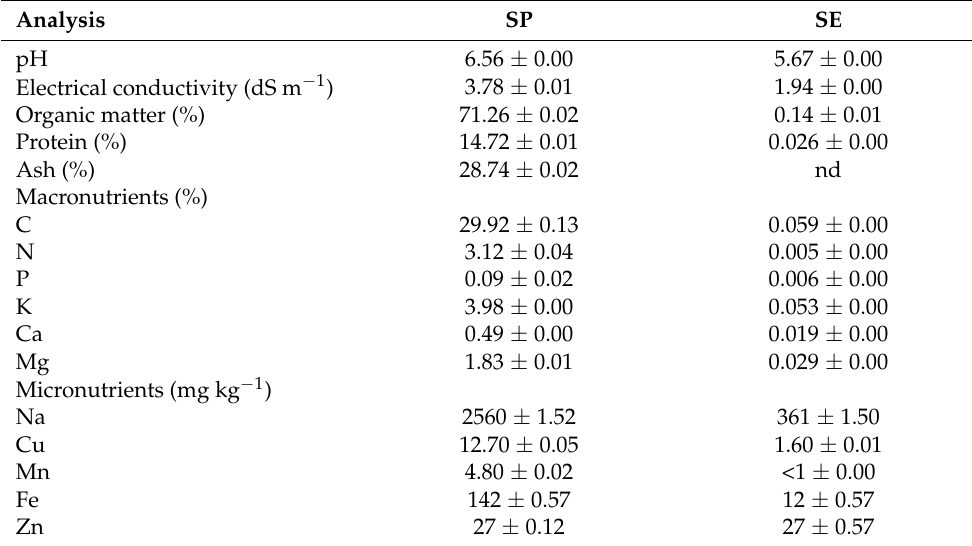
Table 3. Physicochemical characteristics of seaweed powder and seaweed extract from Ulva ohnoi